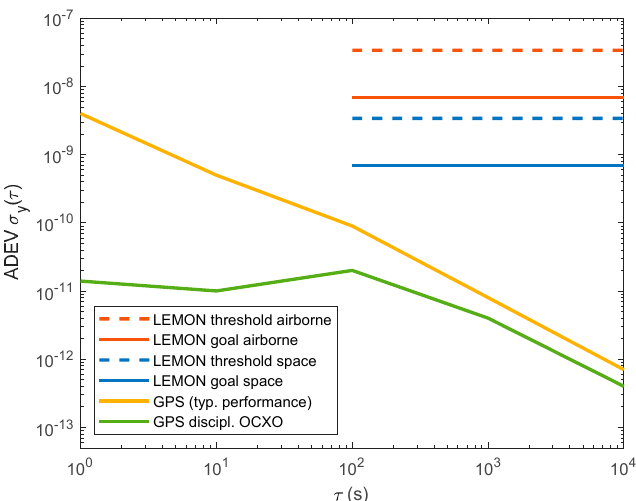
Figure 18. Stability requirements (Allan deviation, ADEV) for the LEMON airborne instrument and future spaceborne instruments together with typical stability performance of Global Positioning System (GPS) and a GPS-disciplined oven-controlled quartz crystal oscillator (OCXO).